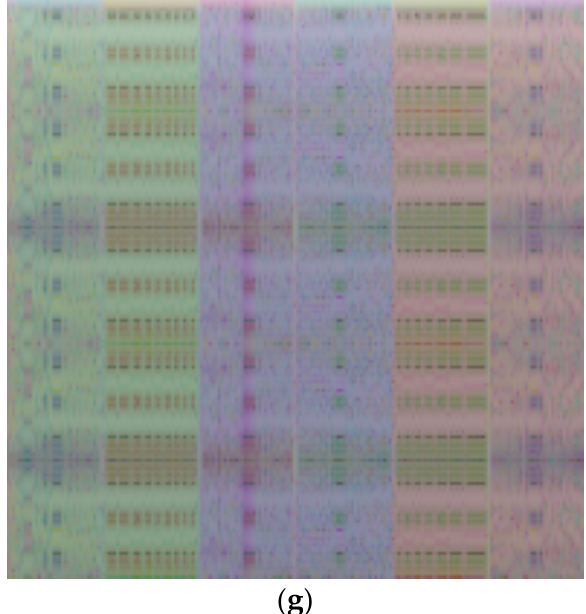
Figure 3. Spectrogram-based image obtained from one electrical cycle of the three-phase shunt voltage waveforms. ( a ) Normal condition; ( b ) when snubber resistance has degraded in S AH ; ( c ) when snubber resistance has degraded in S AL ; ( d ) when snubber resistance has degraded in S BH ; ( e ) when snubber resistance has degraded in S BL ; ( f ) when snubber resistance has degraded in S CH ; ( g ) when snubber resistance has degraded in S CL .